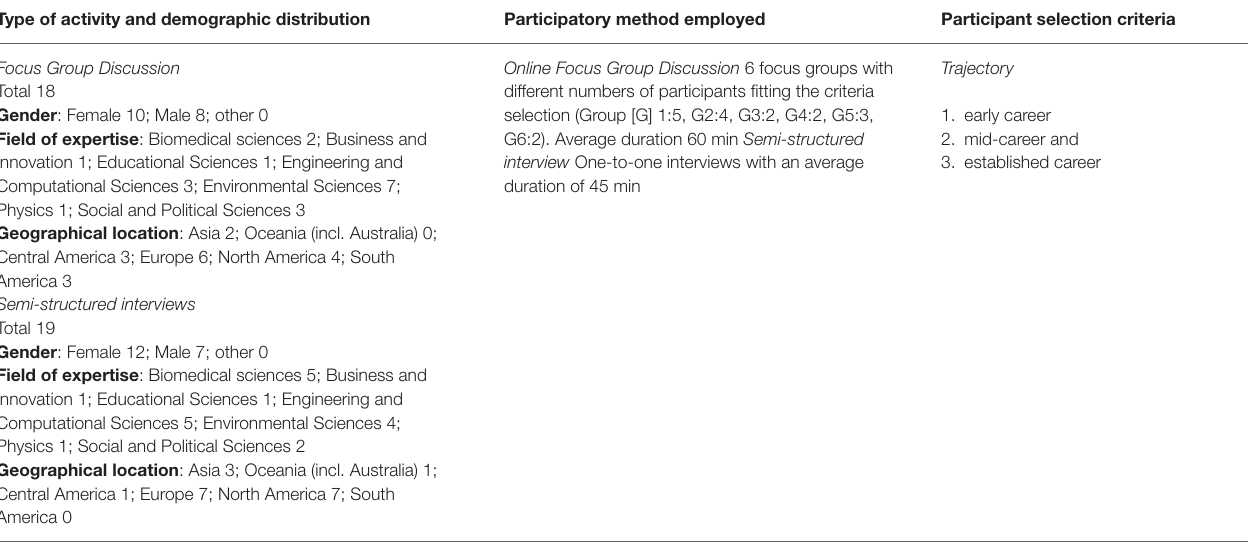
TABLE 3 | Participants from the Scientific Community: method, demographic distribution and fulfillment of the selection criteria. Type of activity and demographic distribution